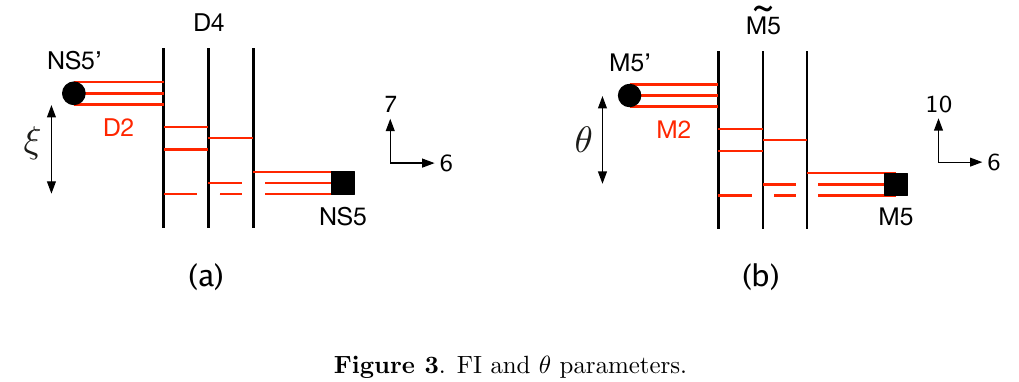
Figure 3 . FI and (cid:18) parameters.